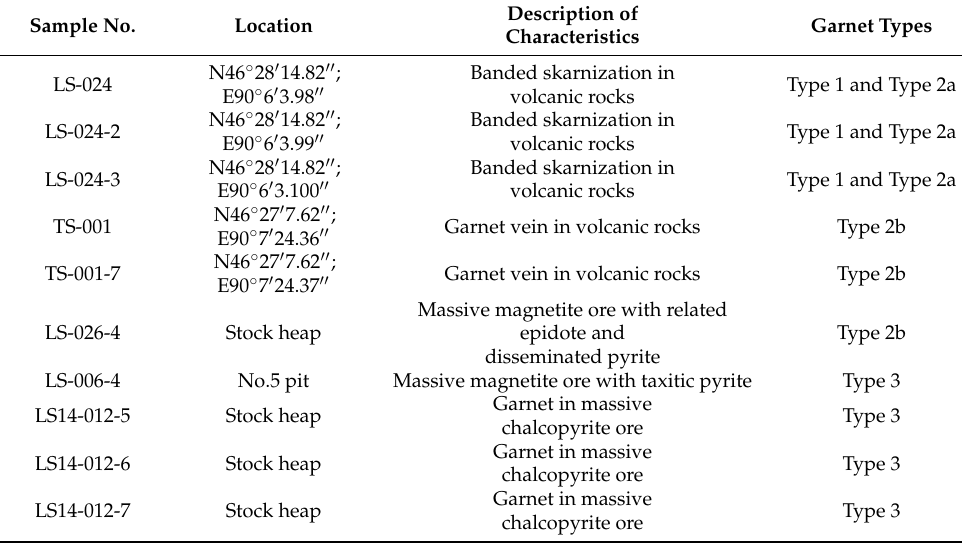
Table 1. Descriptions of sampled garnets from the Laoshankou deposit. Sample